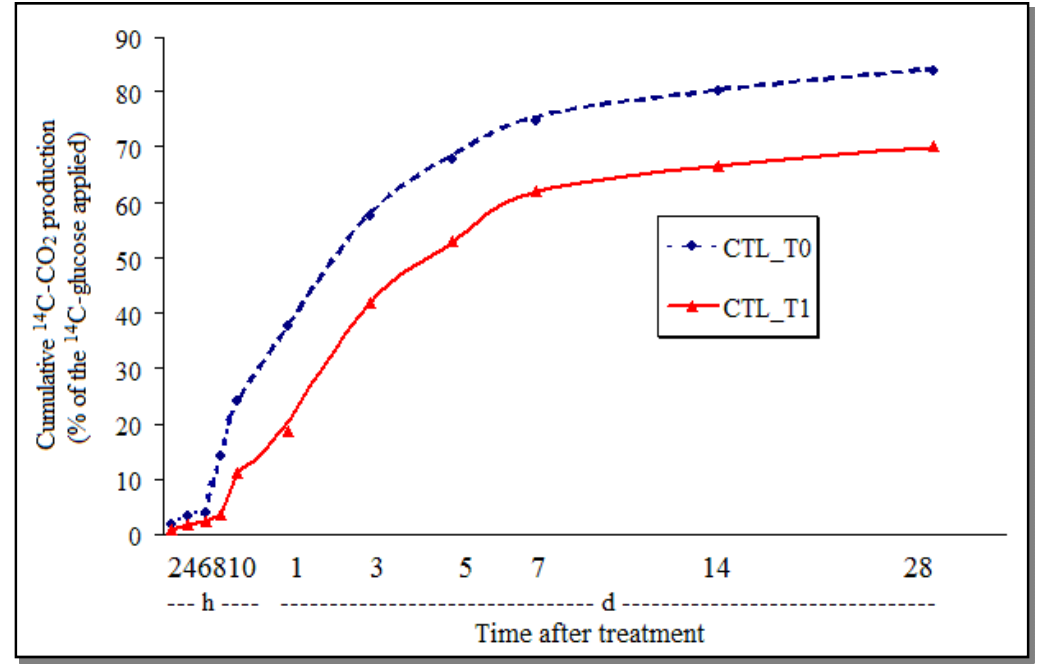
from 14 C-glucose by the soil GHE 2